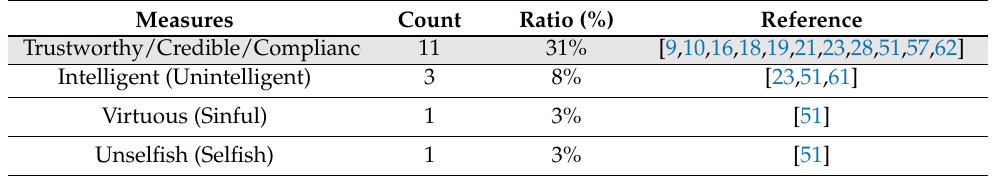
Table 10. Measures of